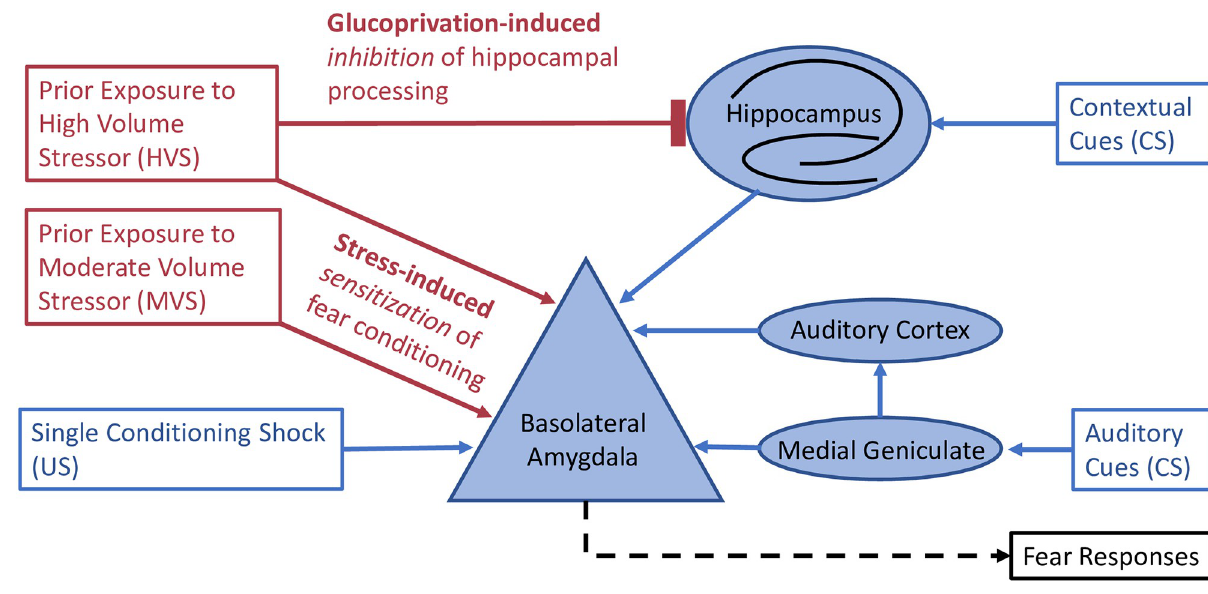
Fig 6. Schematic of hypothesized mechanism.